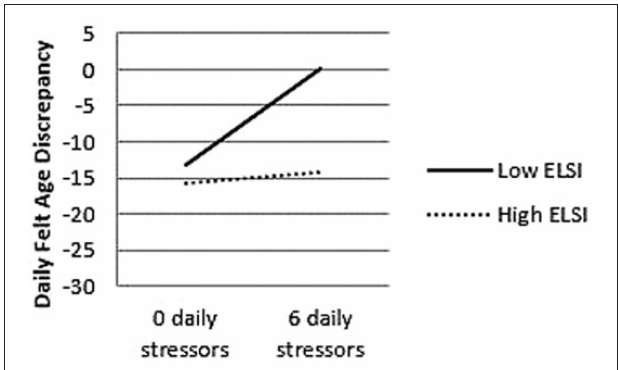
FIGURE 3 | Effects of daily and major life stressors on subjective age. Results from Bellingtier et al. (63) show that those with fewer major life stressors (measured by the Elder Life Stress Inventory, ELSI) show greater increases in daily felt age in response to a stressor compared to those with higher levels of life